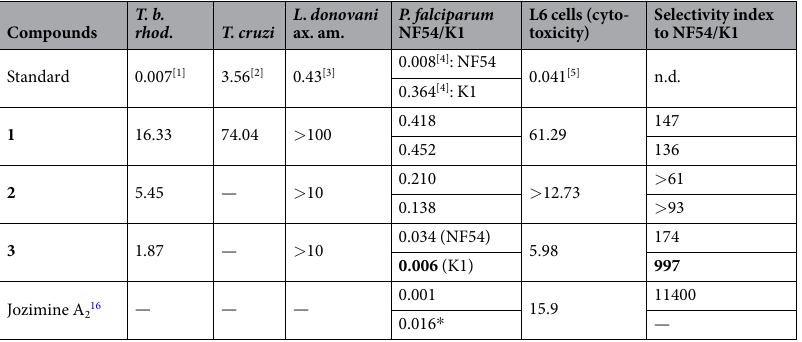
Table 2. Biological evaluations of 1–3 against Plasmodium falciparum (strains: NF54 and K1), Trypanosoma brucei rhodesiense , T. cruzi , and Leishmania donovani . Also the cytotoxicities against rat skeletal myoblasts (L6 cells) were determined (IC 50 in µ M). The profile of the dimeric naphthylisoquinoline alkaloid jozimine A 216 is used for comparison of the antiplasmodial activities. [1] Melarsoprol. [2] Benznidazole. [3]